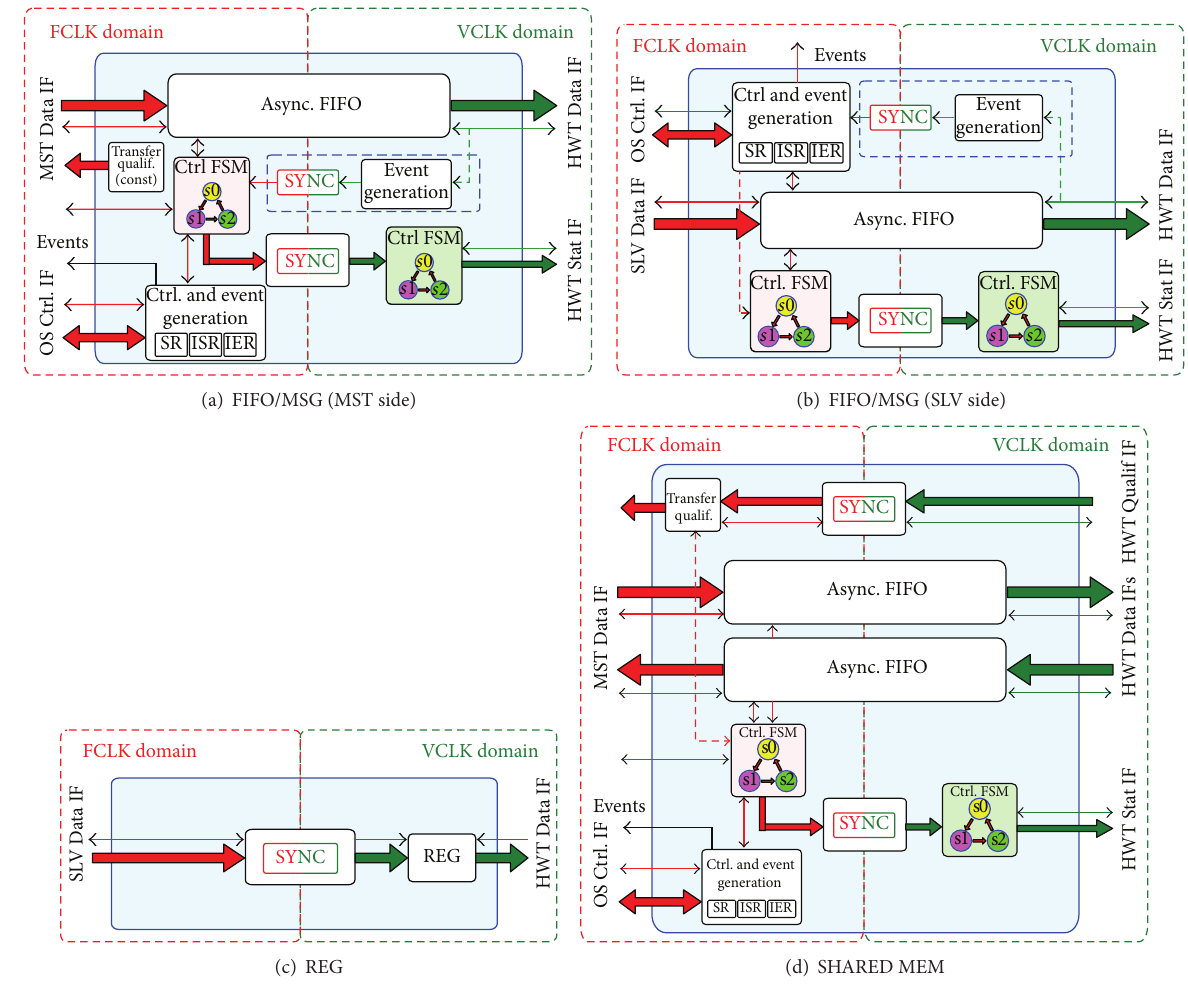
Figure 14: Hardware-side Channel Interface